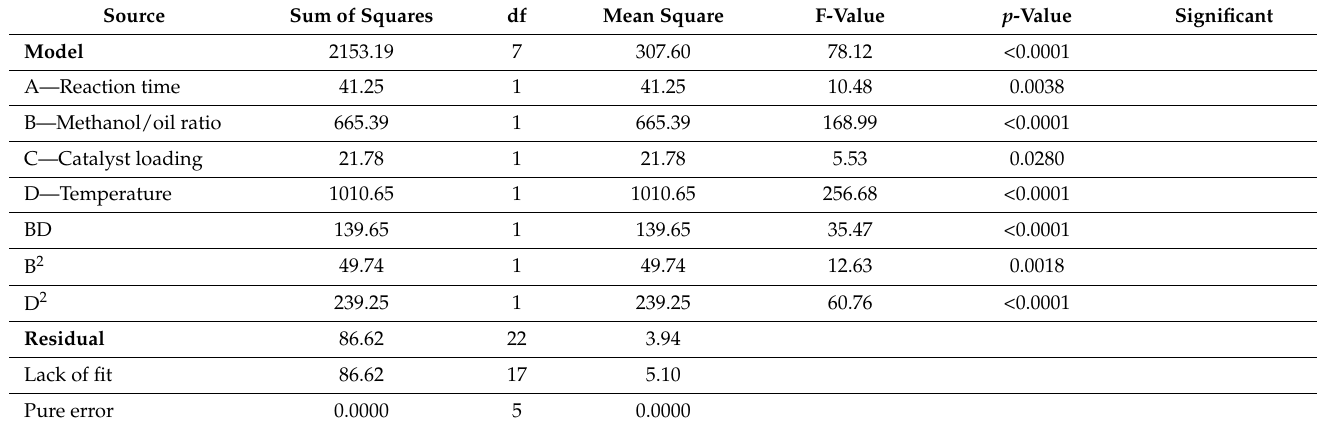
Table 6. ANOVA Analysis for Biodiesel Results.